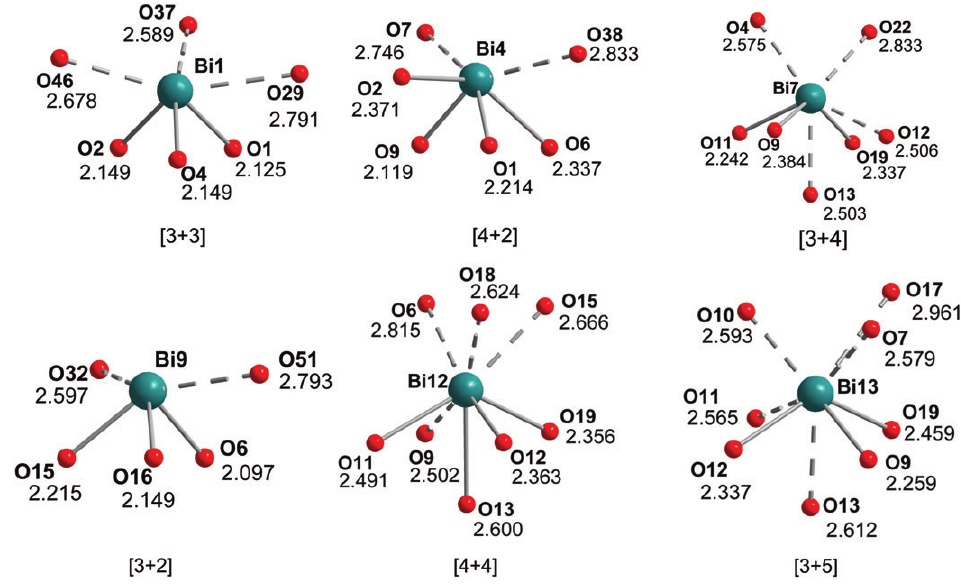
Figure 3 Selected bismuth coordination spheres in cluster 1 . The Bi - O bond lengths are given in Å . The coordination numbers of the bismuth atoms are shown in square brackets.